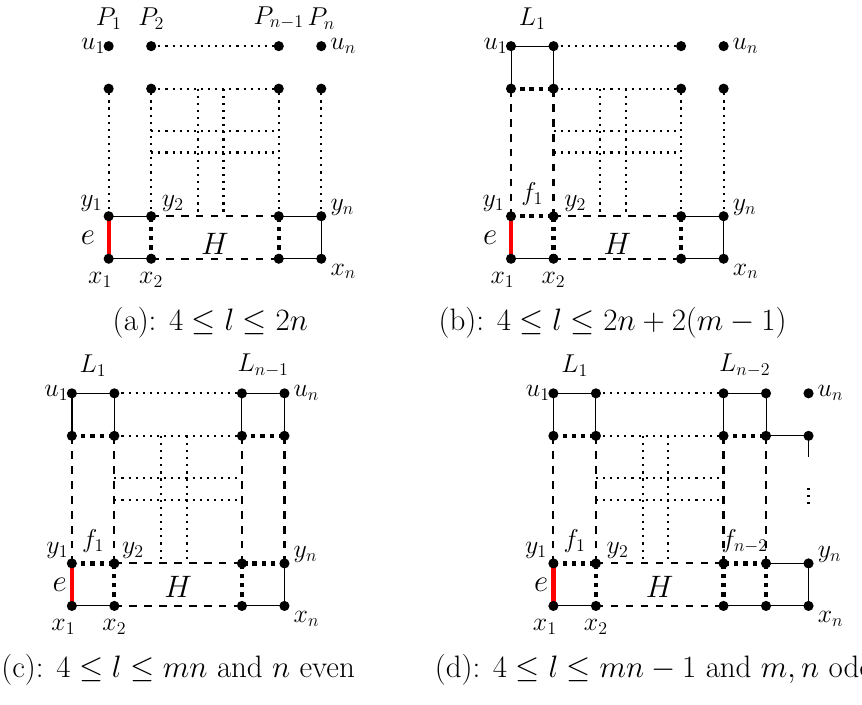
Figure 1: Cycles in P (cid:3) Q containing the edge